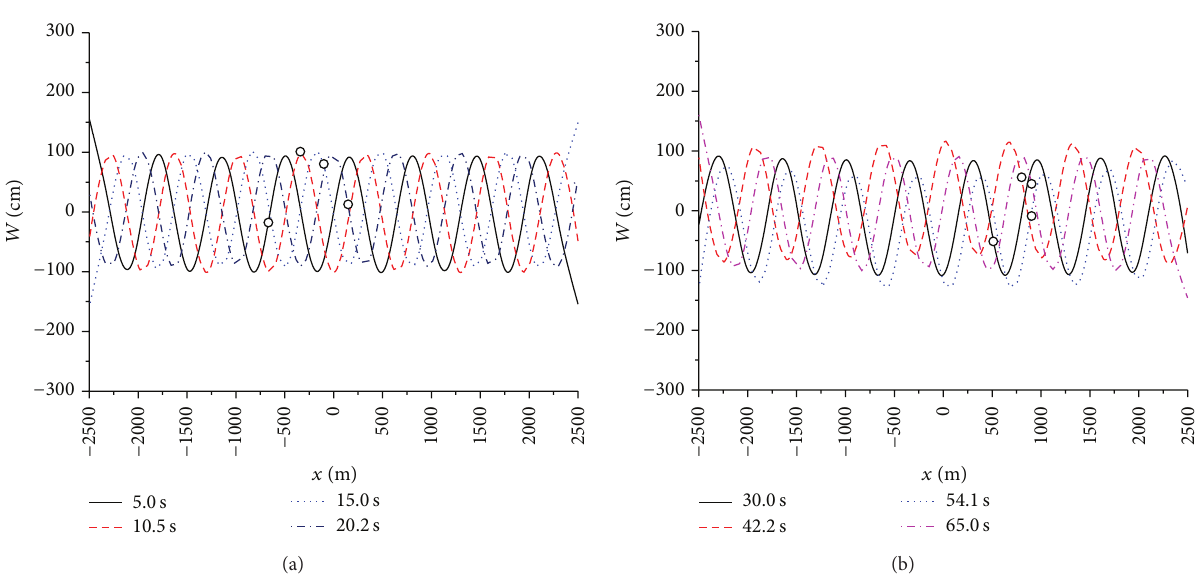
Figure 12: Spatial profiles of the deflection subjected to landing of airplane in regular wave